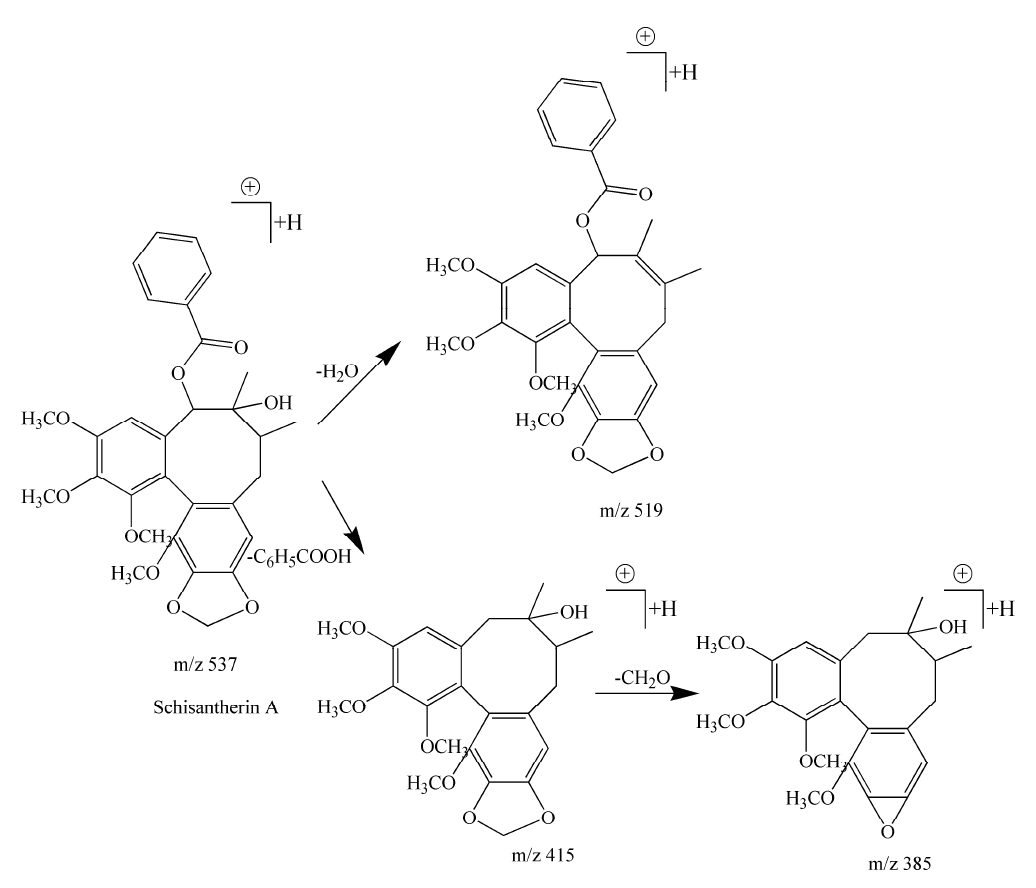
Figure 3. The fragmentation pathways of schisandrol A in positive ion mode.